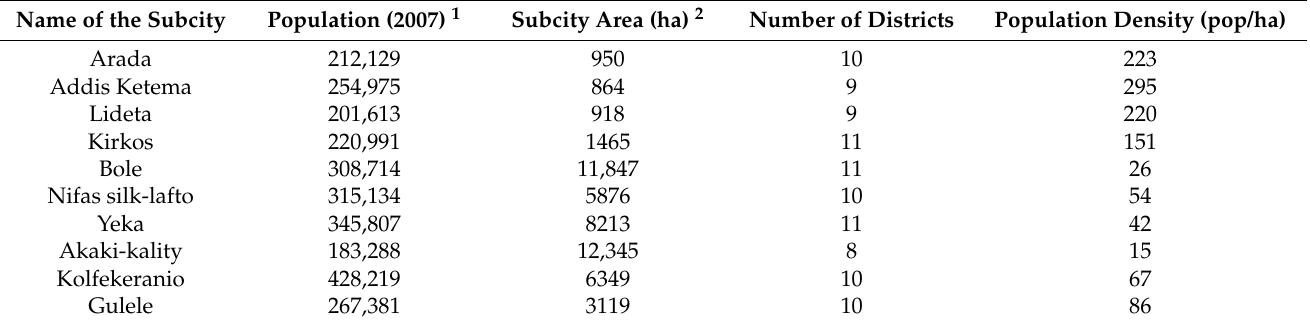
Table 1. Characteristics of the ten subcities of Addis